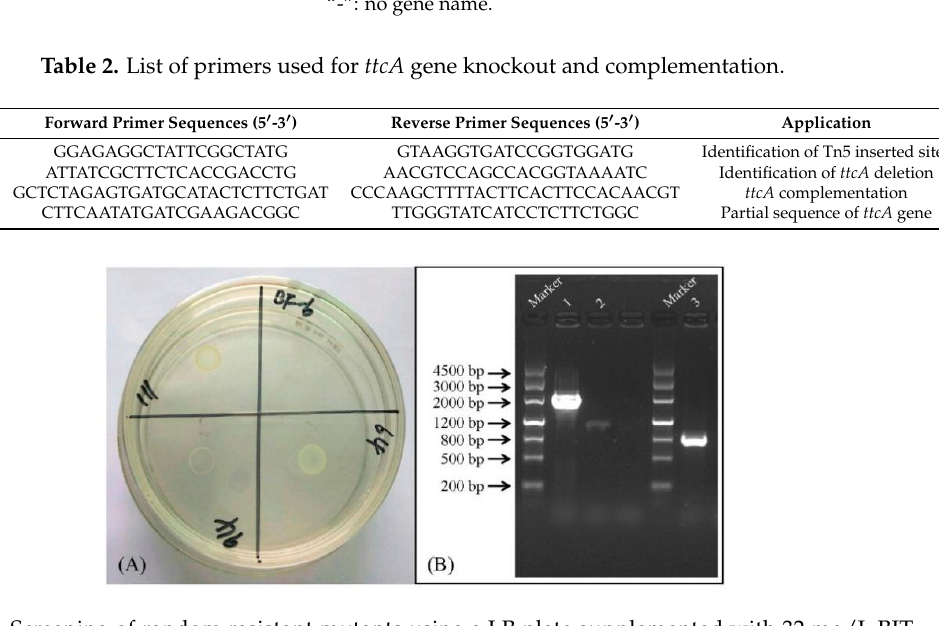
Figure 1. Screening of random resistant mutants using a LB plate supplemented with 32 mg/L BIT ( A ) and identification of ∆ ttcA and ∆ ttcA -com through PCR ( B ). Lane 1: C. werkmanii BF-6 (Control); Lane 2: ∆ ttcA ; Lane 3: ∆ ttcA